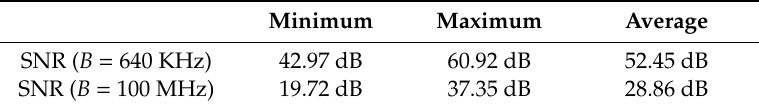
Table 2. Typical signal-to-noise ratio (SNR) in indoor